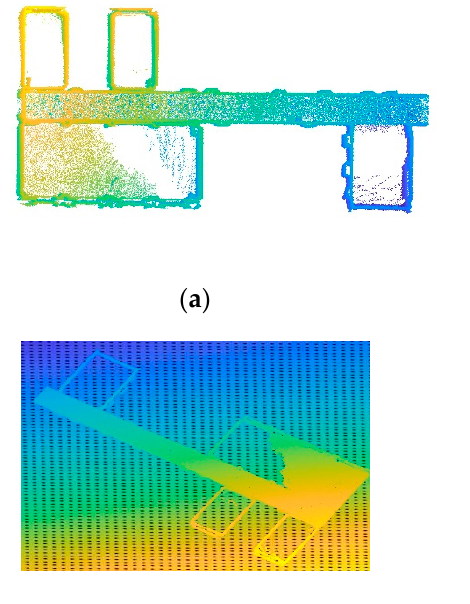
Figure 3. PCA is used to find cross-sections of the data: ( a ) raw point cloud data; ( b ) suppose that composed of point clouds and obtained from PCA; ( c , d ) the plane fitted in the raw data by PCA.